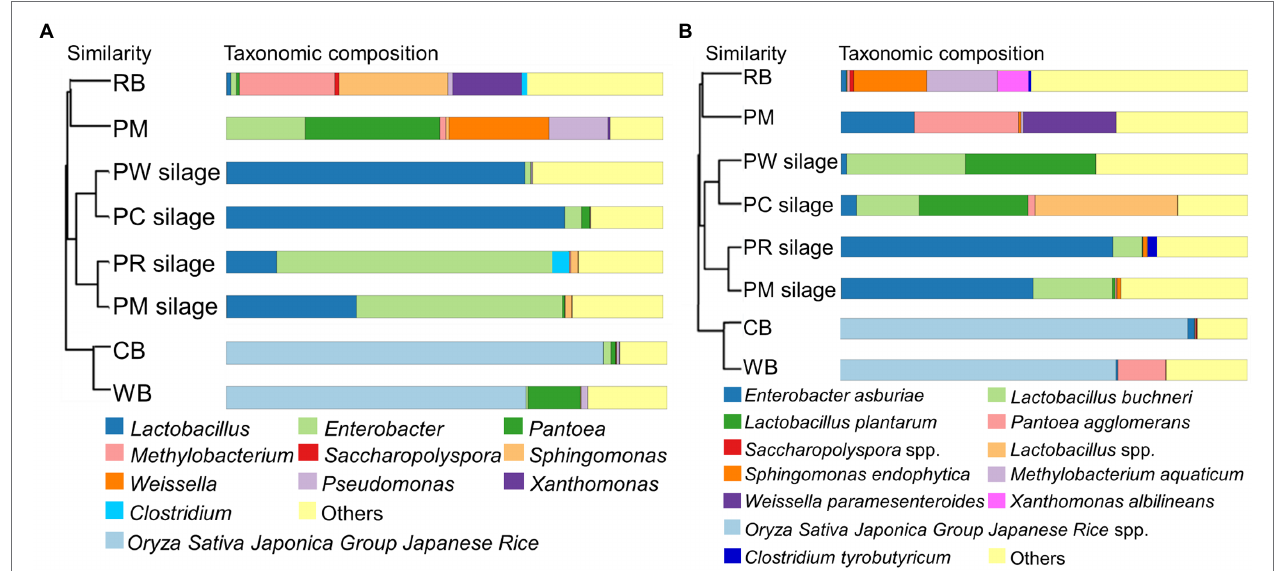
FIGURE 1 | UPGMA hierarchical cluster tree based on the weighted uniFrac distance at the genus (A) and species (B) level of the PM, CB, RB, WB material, and their silage. UPGMA, unweighted pair group method with arithmetic mean; PM, paper mulberry; CB, corn bran; RB, rice bran; WB, wheat bran; PC, PM + CB; PR, PM + RB; PW, PM +